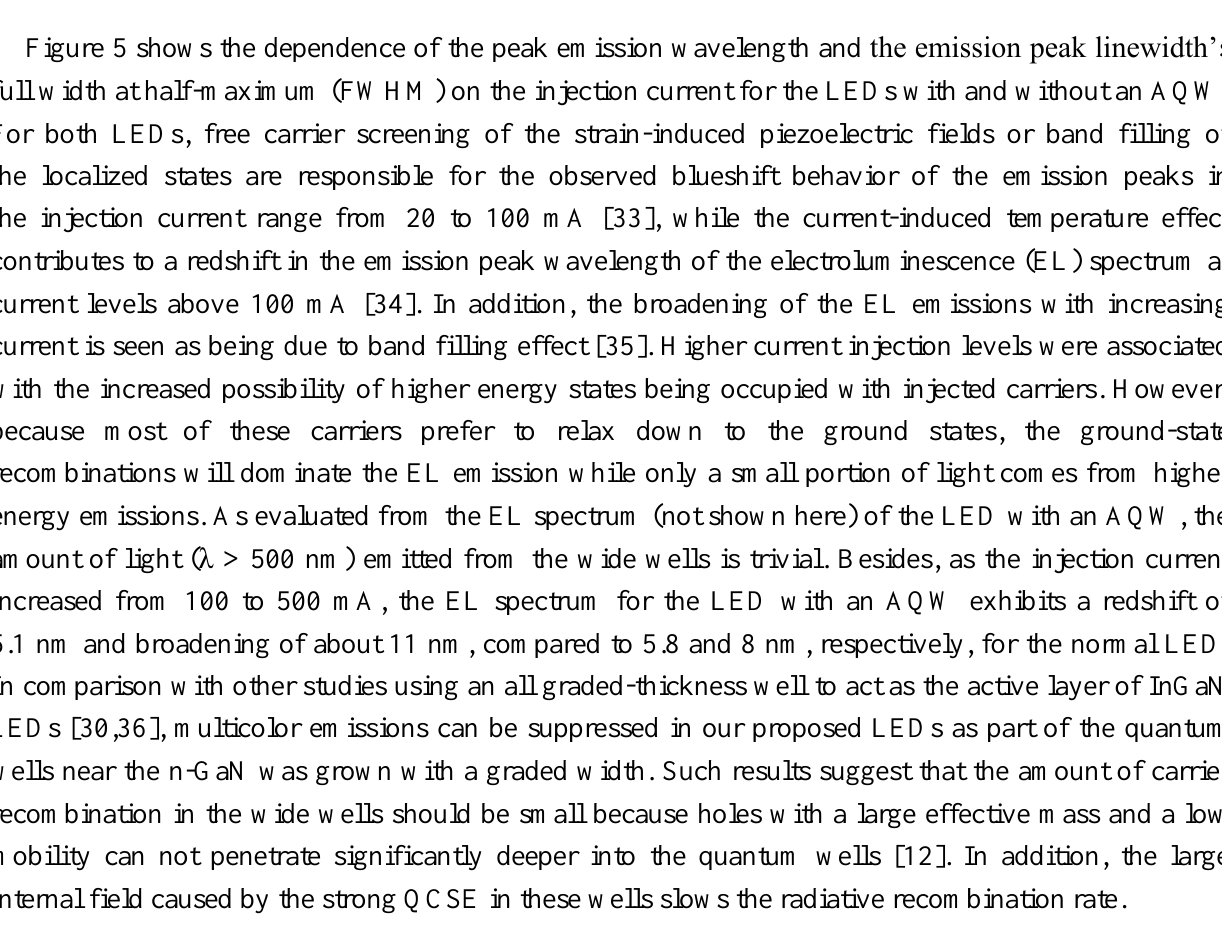
Figure 5. Dependence of the peak emission wavelength and the emission peak linewidth FWHM on injection current for the LEDs with and without an